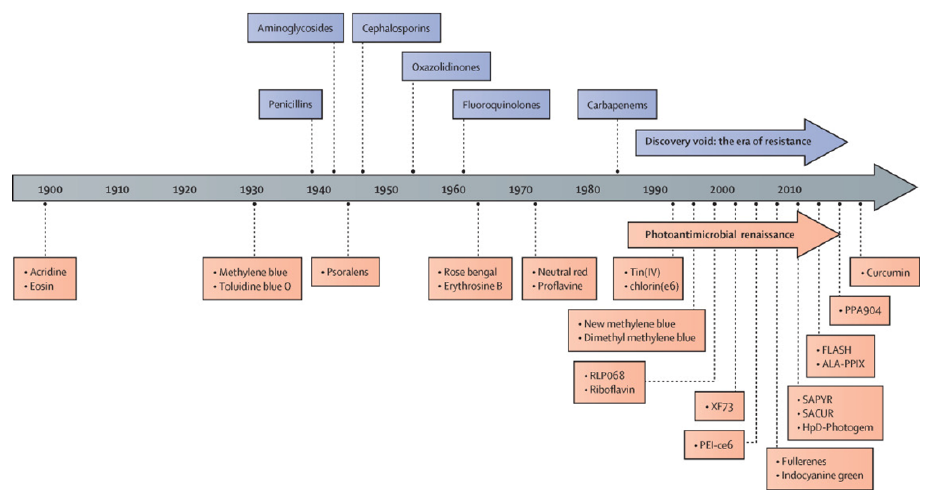
Figure 2. History of antimicrobial photodynamic therapy. RLP068: tetracationic Zn(II) ph- thalocyanine chloride; XF73: positively charged porphyrin; PEI-ce6: polyethyleneimine chlo- rin(e6) conjugate; SAPYR: perinapthenone